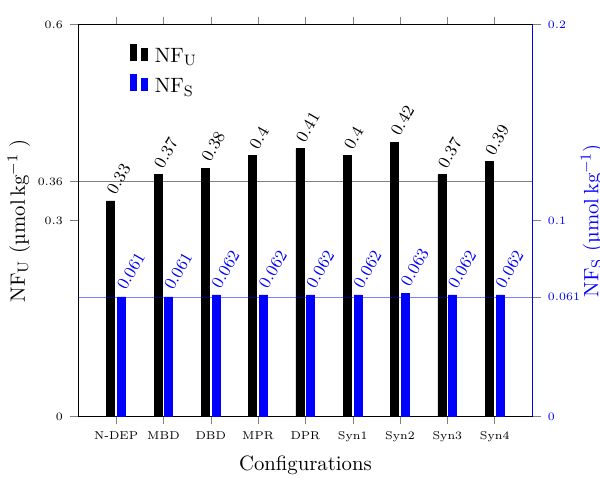
Figure 3. Sensitivity of simulated steady-state concentrations of nitrogen fixers NF U and NF S in the U and S boxes, respec- tively. Horizontal grey and light blue lines represent the NF U and NF S concentrations in the control configuration, respectively. Syn1, Syn2, Syn3 and Syn4 denote the “MBD + MPR”, “DBD + DPR”, “MBD + MPR + NDEP”, and “DBD + DPR + NDEP” synthesis configurations defined in Table